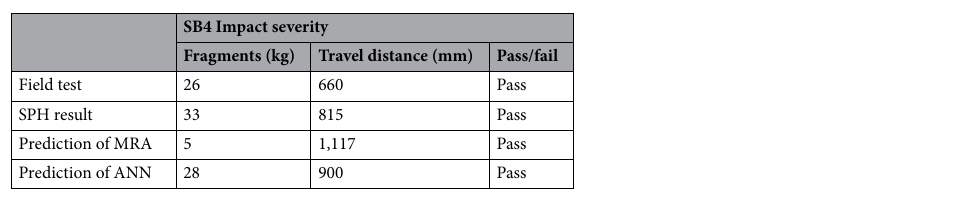
Table 3. Results of field test and